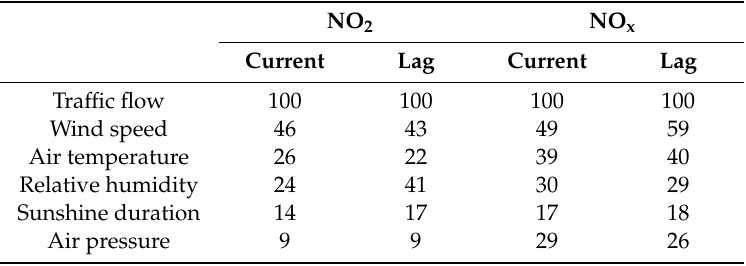
Table 6. Feature importance of variables in Current and Lag models .